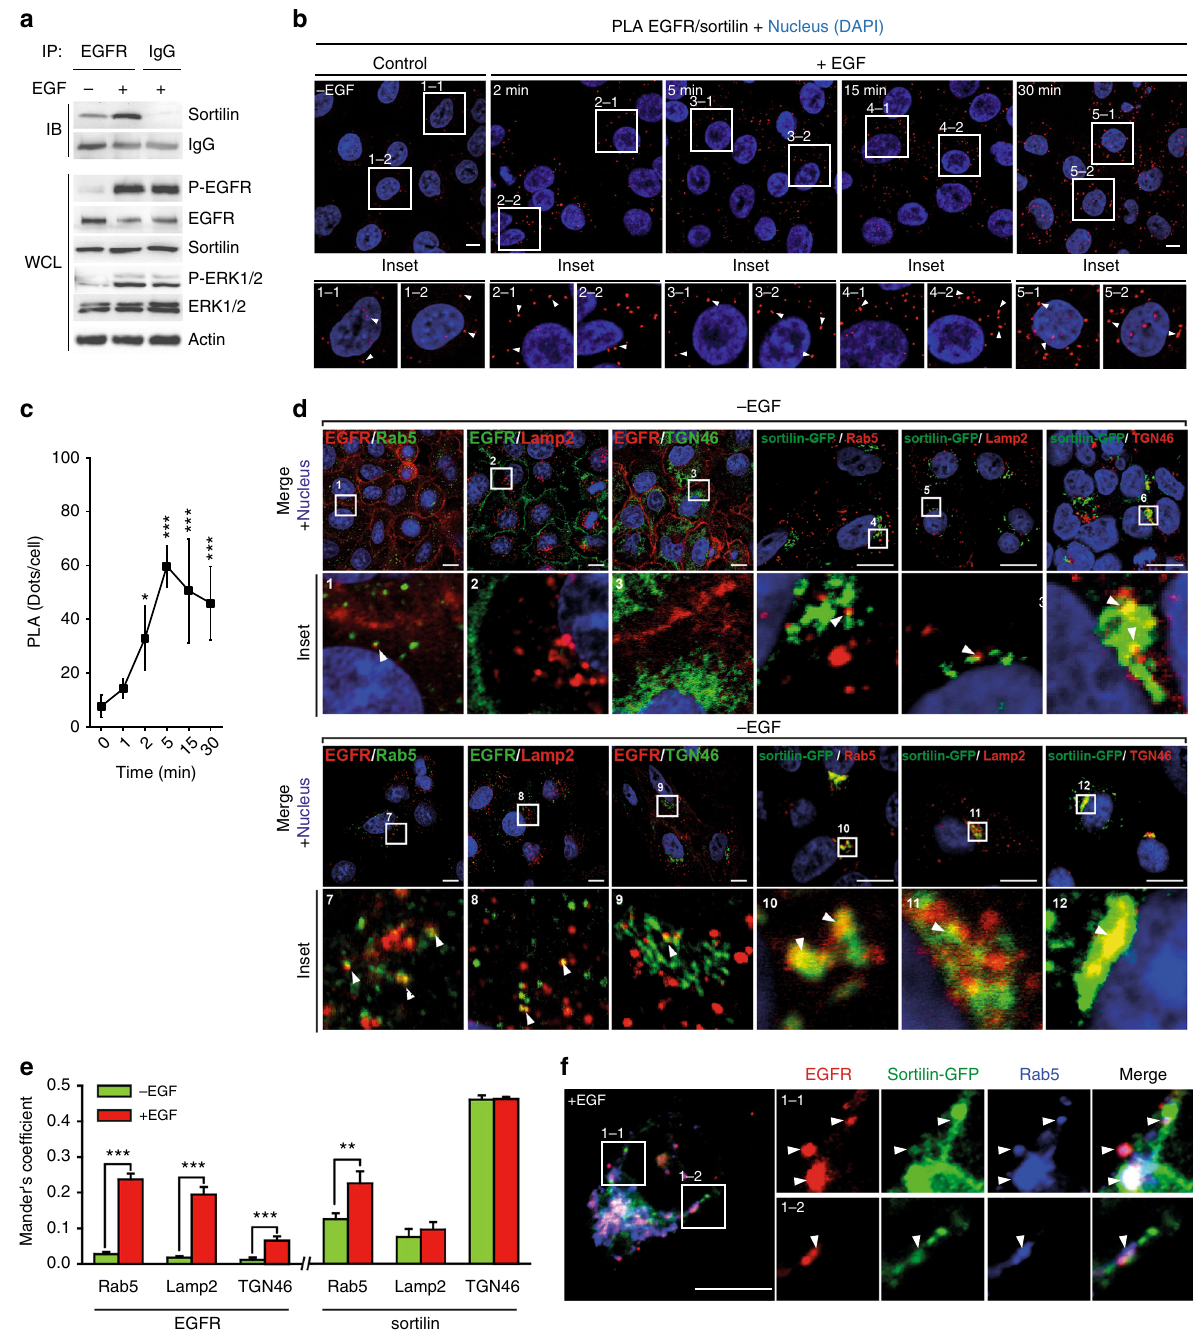
Fig. 1 EGF promotes the EGFR — sortilin interaction. a A549 cells grown in complete cell culture media were stimulated or not with EGF (50 ng/mL) for 30 min. Immunoprecipitations (IP) were performed using anti-EGFR antibody, and the immunocomplexes were immunoblotted (IB) using anti-sortilin antibody (top). In parallel, immunoblots for P-EGFR, EGFR, sortilin, P-ERK, and ERK were performed on whole-cell lysates (WCL); the isotypic lane Immunoglobulin G (IgG) represents the IP control. b Proximity ligation assays (PLA) were performed on A549 cells, non-stimulated or stimulated with EGF (50 ng/mL) for 2, 5, 15, and 30 min. Red spots indicate sites of proximity ligation assay ampli fi cation, re fl ecting the EGFR — sortilin interaction (white arrows). Scale bar, 10 µ m. c Quanti fi cation of PLA time course, in comparison with non-stimulated cells. d A549 cells were stimulated or not with EGF (50 ng/mL) for 30 min, and then co-immunolabeled for EGFR and markers of the early endosome (Rab5), the late endosome/lysosome (LAMP2) and the trans-Golgi network (TGN46). For sortilin labeling, A549 cells were transiently transfected with sortilin-GFP to adapt a set of functional antibodies, and then immunolabeled for the same markers. Scale bar, 5 µ m. e Quantitative analysis of EGFR or sortilin-GFP co-localization with the aforementioned organelle-speci fi c markers. f A549 cells were transiently transfected with sortilin-GFP, and then stimulated with EGF (50 ng/mL) for 30 min. Next, cells were fi xed and co-immunolabeled for EGFR and Rab5. Scale bar, 10 µ m. All values represent means ± SD, Student ’ s t -test * P < 0.05; *** P < 0.001. Each experiment has been repeated at least three